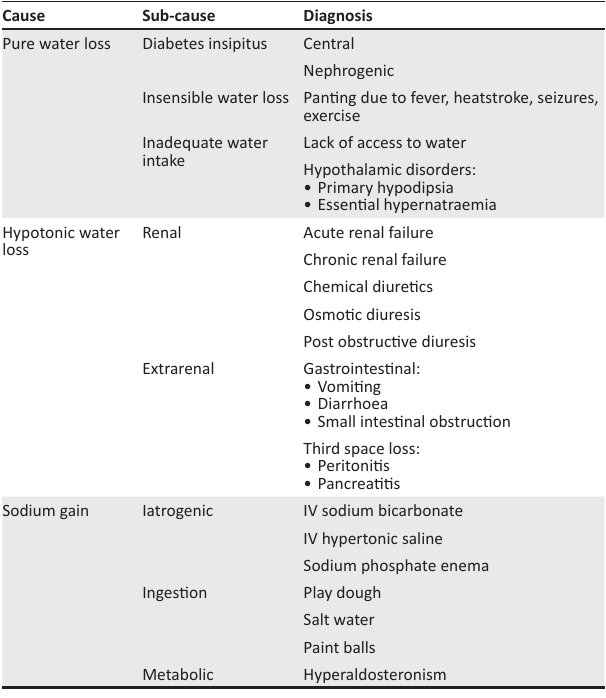
TABLE 1: Causes of hypernatraemia in dogs. Cause Sub-cause